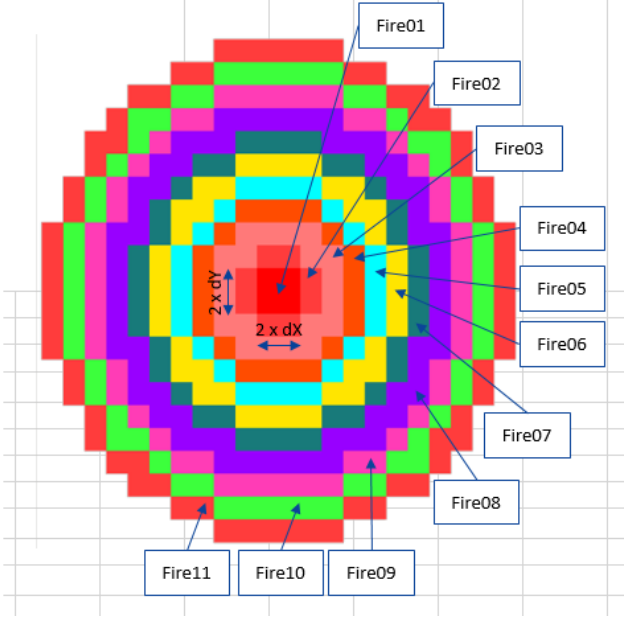
Figure 1. FDS fire vent make-up.